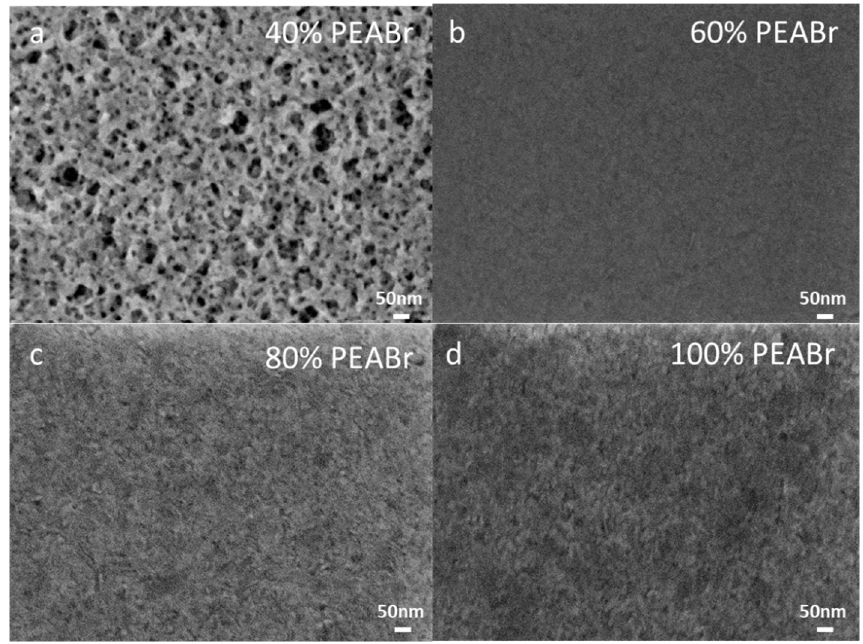
Figure 2. Top-view SEM images of perovskite thin films with ( a ) 40%, ( b ) 60%, ( c ) 80% and ( d ) 100% ratios of PEABr. Table 1. Summary of CsPbCl 0.75 Br 2.25 perovskite films with different ratios of PEABr. PL (nm)